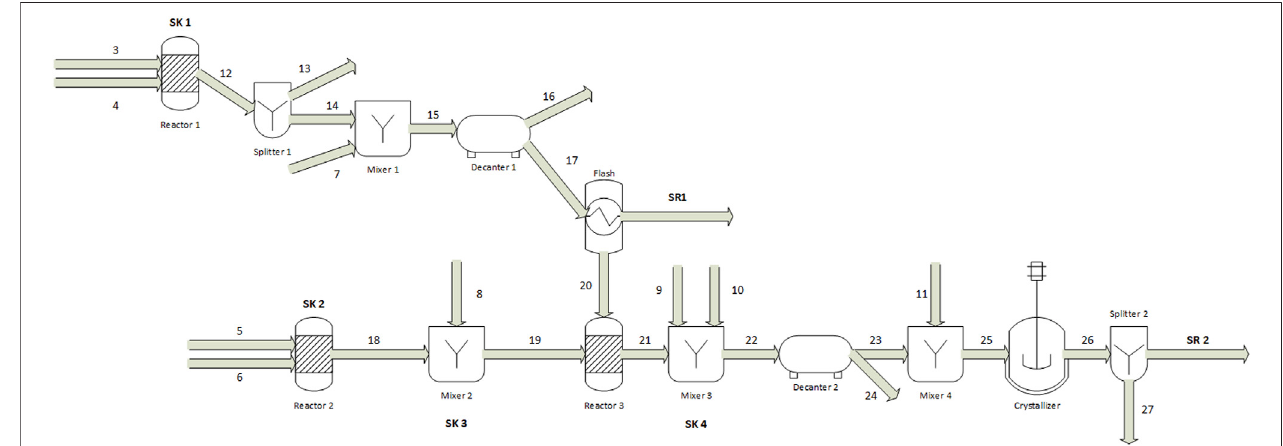
FIGURE 4 | Process fl owsheet for the case study-1 highlighting all process sinks and sources.